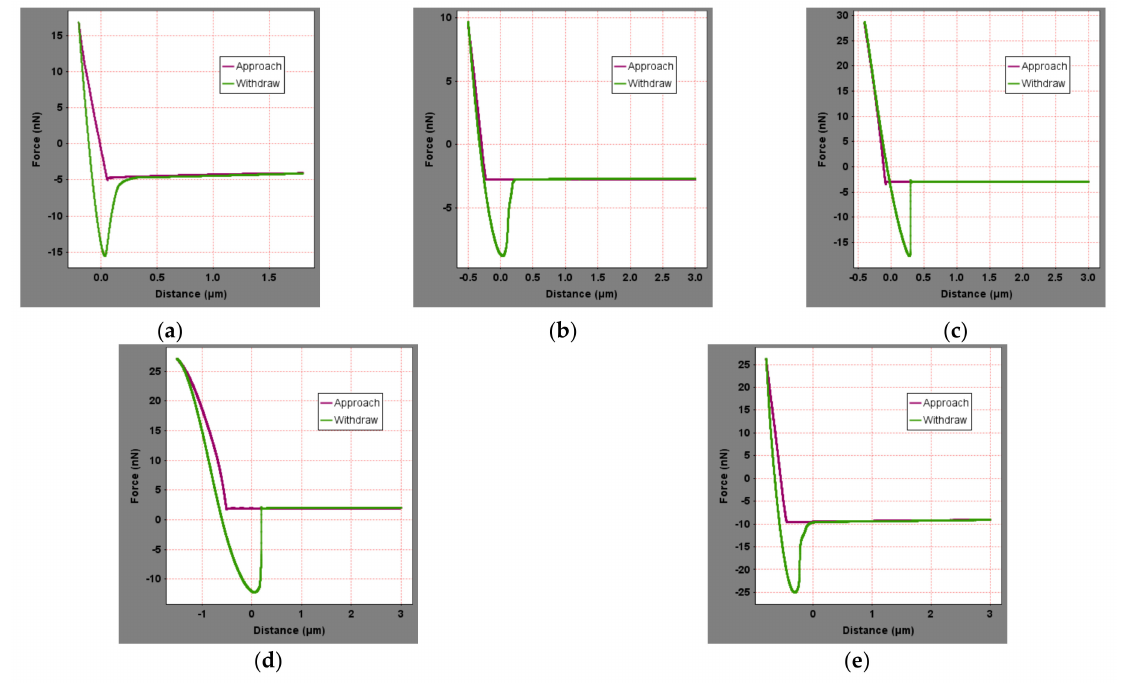
Figure 8. Force curves of aged asphalt binder: ( a ) SK-70, ( b ) KL-70, ( c ) Shell-70, ( d ) SK-90, and ( e )